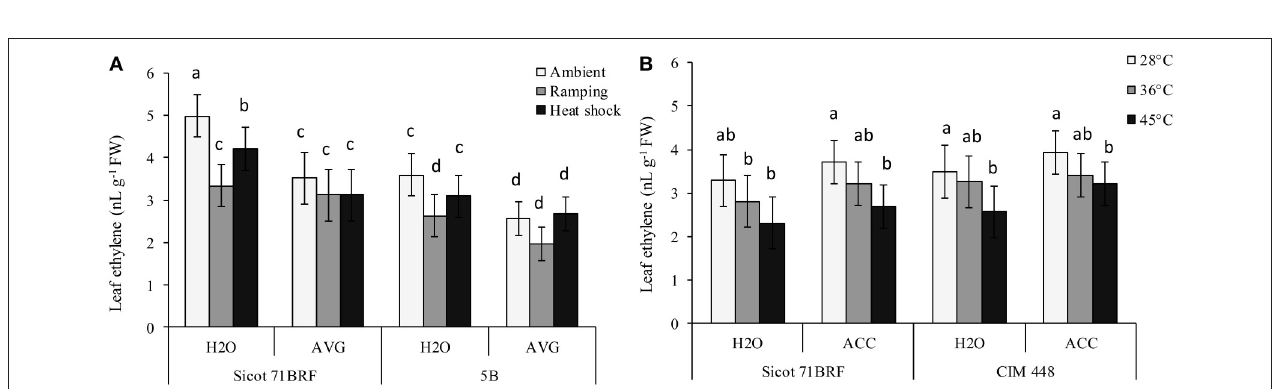
FIGURE 4 | Pollen germination and pollen tube length of (A) Sicot 71BRF (B) 5B genotypes 24h after in vitro incubation under varying temperatures in experiment 1. Pollen germination and pollen tube length of (C) Sicot 71BRF (D) CIM 448 genotypes 24h after in vitro incubation under varying temperatures in experiment 2. Values are the mean of four independent replications, with the error bars representing SE and sample size = 4.